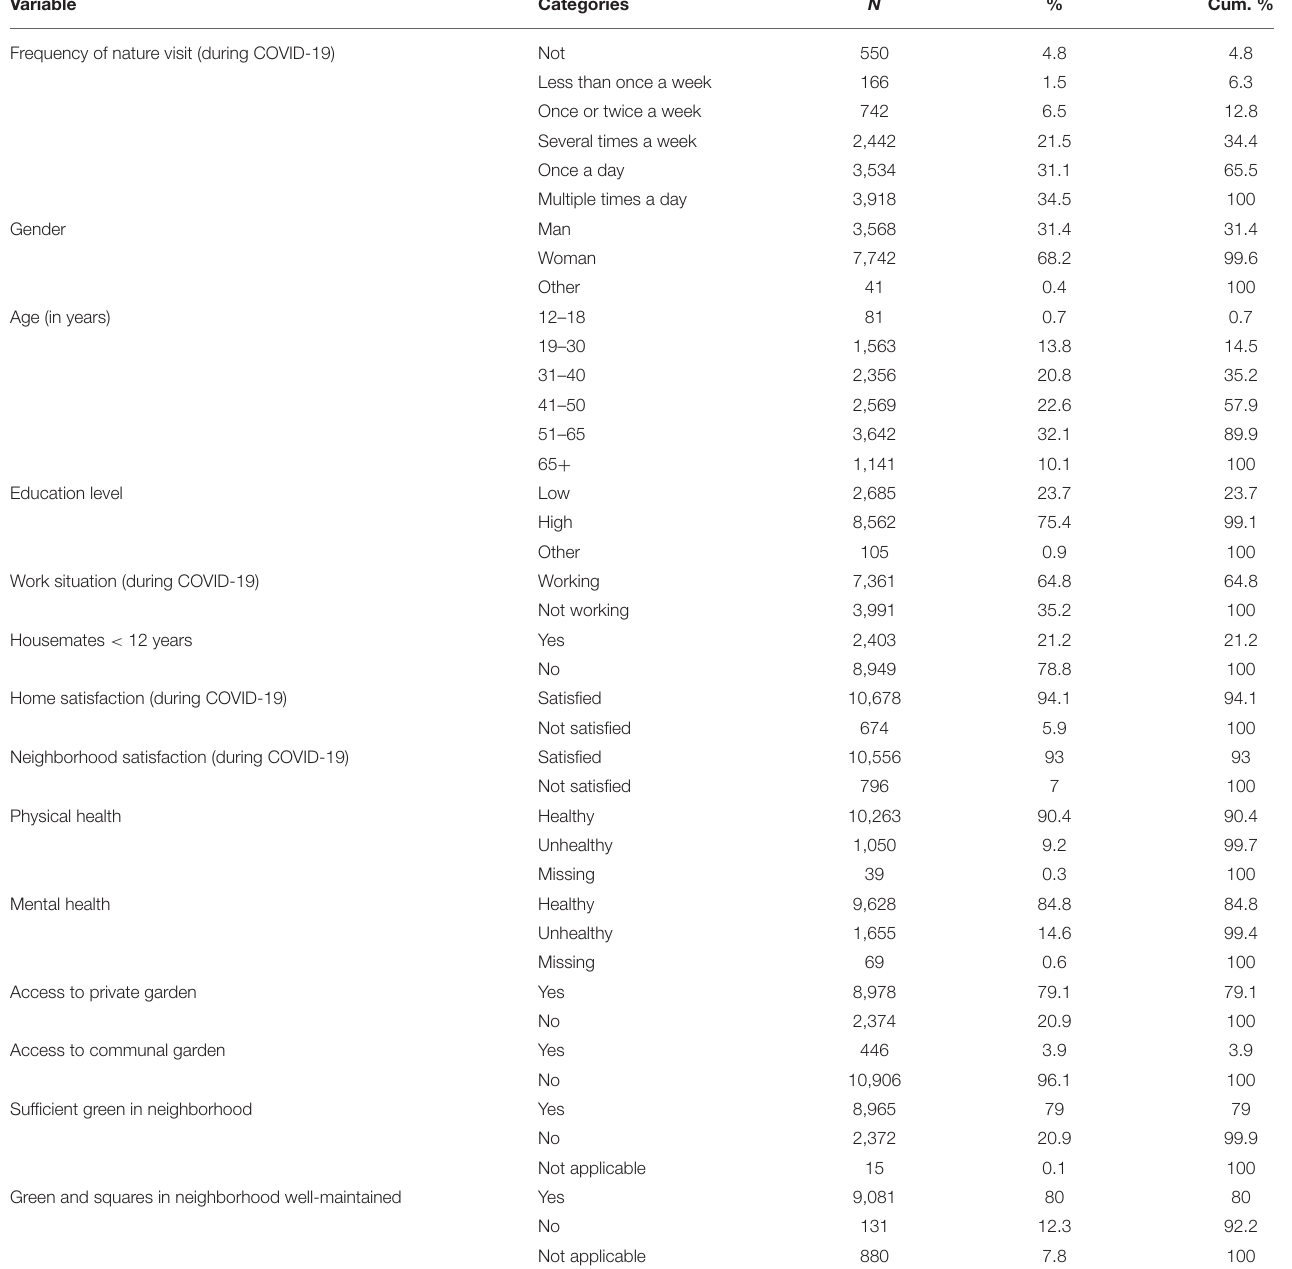
TABLE 1 | Variables overview of frequencies ( N = 11,352).